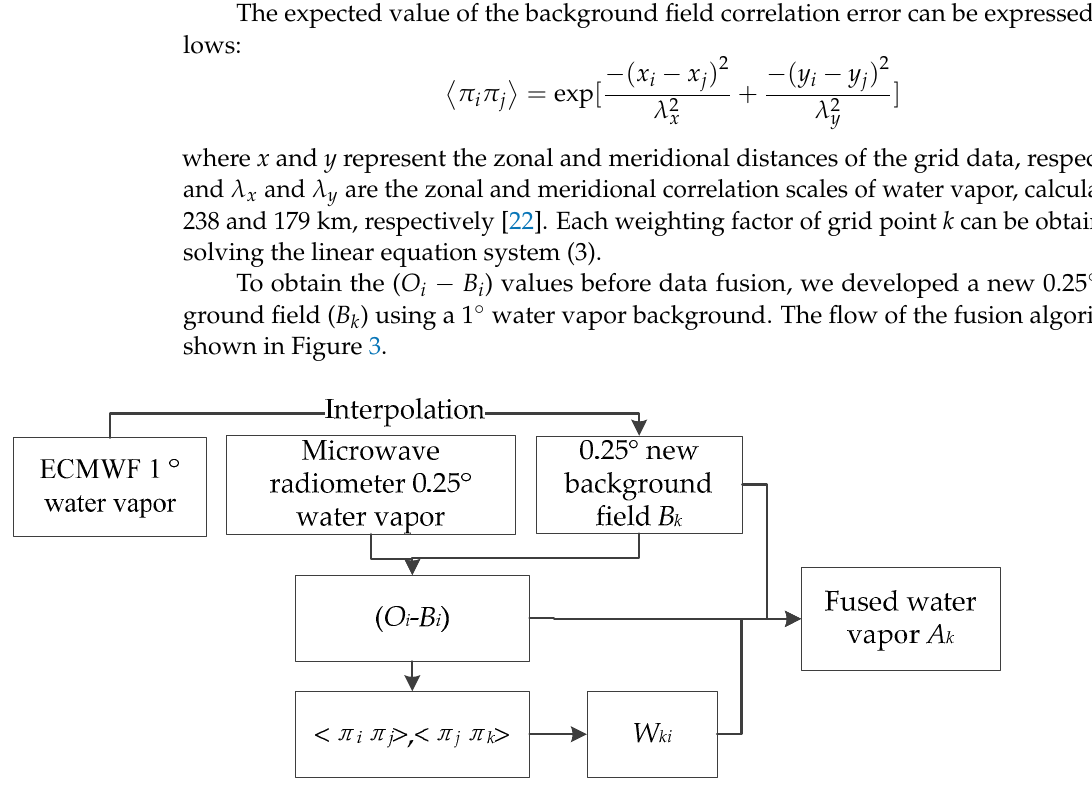
Figure 3. Implementation mechanism of the fusion algorithm for water vapor. A new 0.25° background field ( B k ) was reconstructed using the bilinear interpolation method. Then, ( O i − B i ) was calculated using the radiometer water vapor and new background.